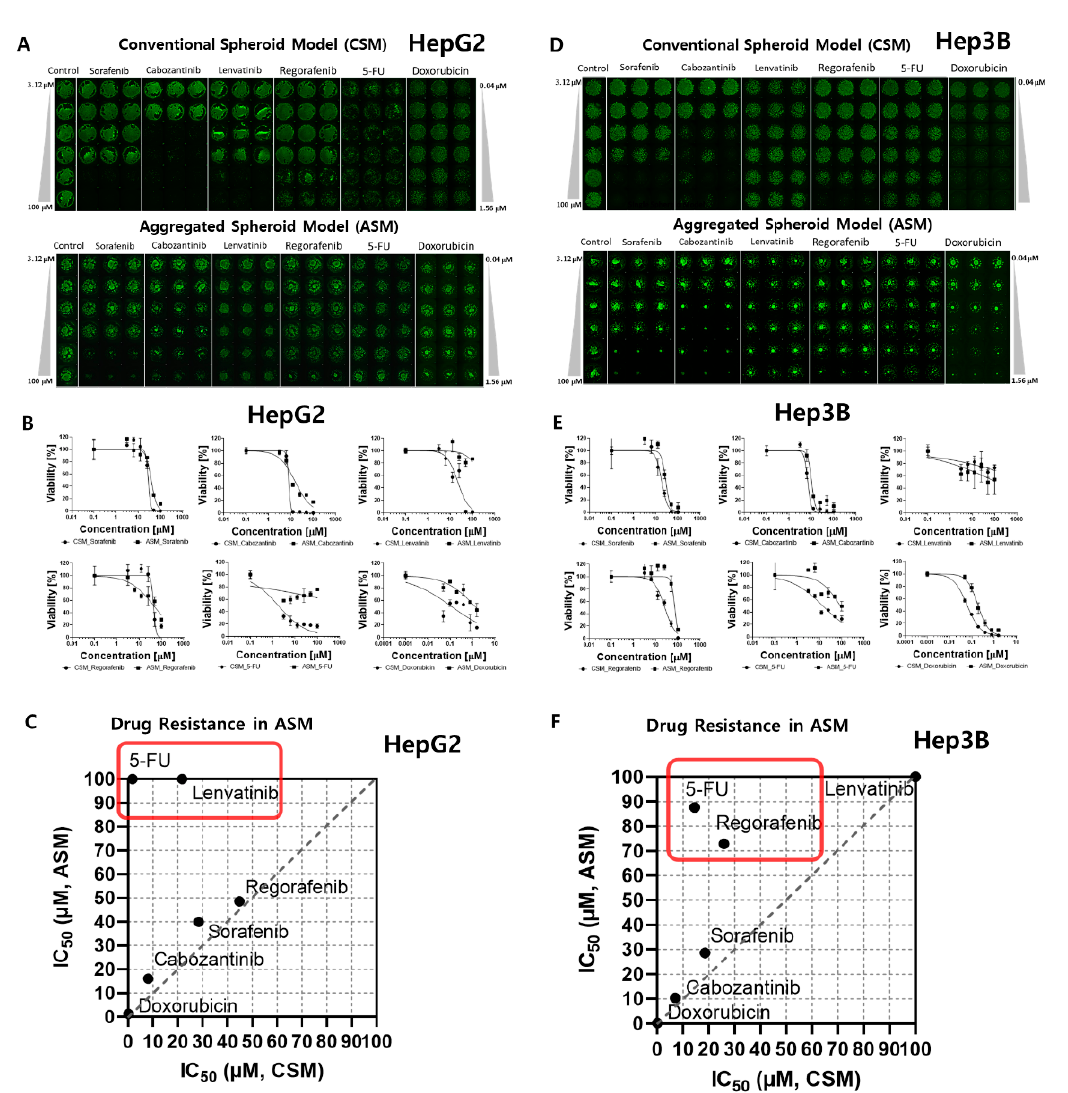
Figure 2. Comparative dose–response curve analysis of six different drugs in 3D cell models. The IC 50 was calculated to compare the 3D live-cell staining dye expression level according to the dose of each of the six drugs. ( A ) Combined image of 3D live HepG2 cells in the CSM and ASM. ( B ) Dose–response curves and a summary table of quantitatively analyzed drug efficacy according to the doses of the six drugs tested in the HepG2 CSM and ASM. ( C ) IC 50 comparison of ASM and CSM in HepG2. 5-FU and Lenvatinib showed higher drug resistance in the ASM than CSM. ( D ) Combined image of 3D live Hep3B cells in the CSM and ASM. ( E ) Dose–response curves and a summary table of quantitatively analyzed drug efficacy according to the doses of the six drugs tested in the Hep3B CSM and ASM. ( F ) IC 50 comparison of ASM and CSM in Hep3B. 5-FU and Regorafenib showed higher drug resistance in the ASM than